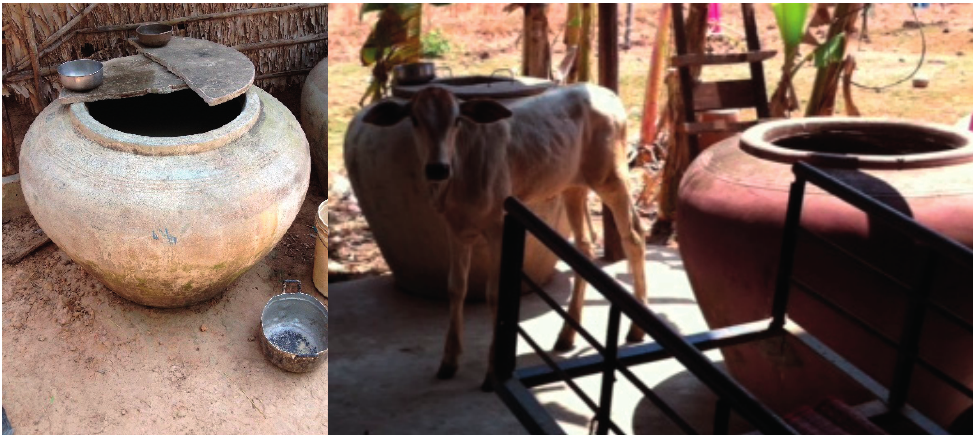
Figure 2. Water storage in the home